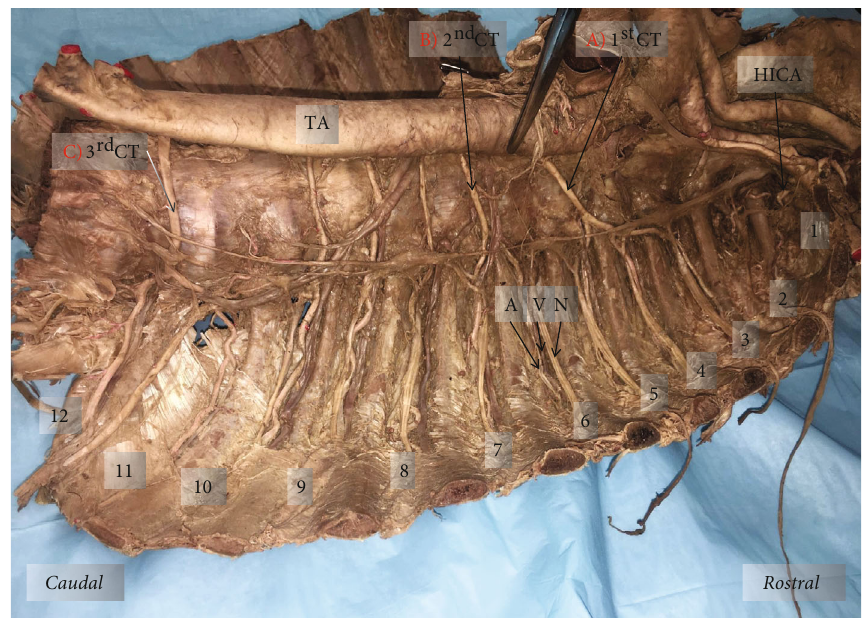
Figure 4: Left posterior thoracic wall with exposed ICS: (a) superior common trunk arising from TA between 6th and 7th thoracic vertebrae supplying 3rd-5th ICS; (b) middle common trunk arising from TA between 7th and 8th thoracic vertebral level supplying 6th-7th ICS; (c) inferior common trunk arising from TA between 12th thoracic and 1st lumbar vertebrae supplying 11th ICS and subcostal space. Numbers 1-11: ICS number; 12: subcostal space; HICA: highest intercostal artery; 1st CT: fi rst (superior) common trunk; 2nd CT: second (middle) common trunk; 3rd CT: third (inferior) common trunk; TA: thoracic aorta.